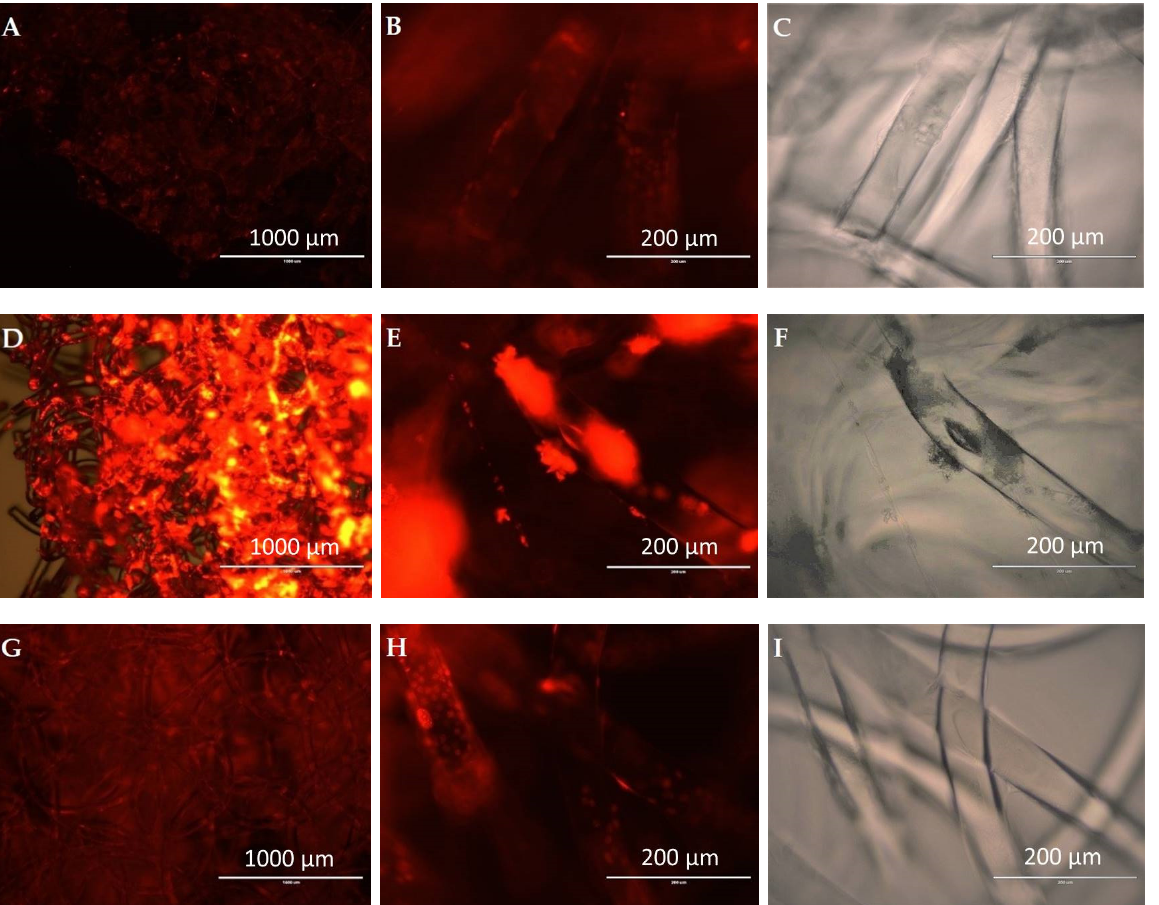
Figure 13. Melt electrospun scaffolds cultured with LSCs stained with Incucyte ® Nuclight Rapid Red fluorescent dye: ( A ) single PLA (magnification 4×), ( B ) single PLA (magnification 20×), ( C ) bright field image of single PLA (magnification 20×), ( D ) PLA/silk fibroin (magnification 4×), ( E ) PLA/silk fibroin (magnification 20×), ( F ) bright field image of PLA/silk fibroin (magnification 20×), ( G ) PLA/gelatin (magnification 4×), ( H ) PLA/gelatin (magnification 20×) and (I) bright field image of PLA/gelatin (magnification 20×). Detection (531/40 nm excitation; 593/40 nm emission).